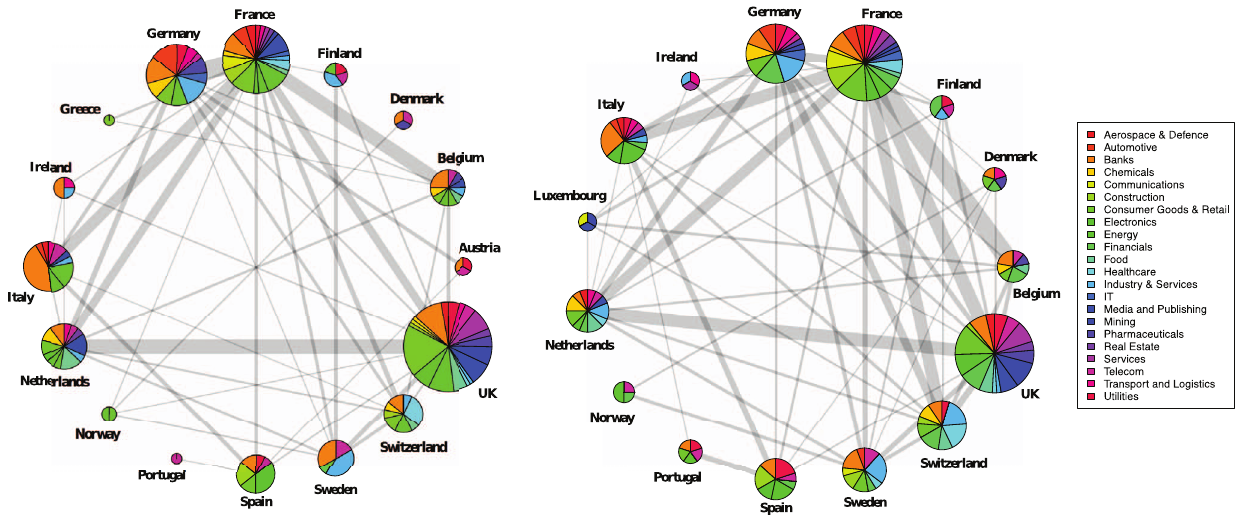
Figure 1. Board interlocks among EU countries in 2005 (Left) and 2010 (Right). The size of a node is proportional to the square root of the number of companies from that country, the thickness of an edge is proportional to the number of interlocks between the boards of companies from the connecting countries. Each node reports in a pie-chart the distribution of companies among the sectors listed on the right.